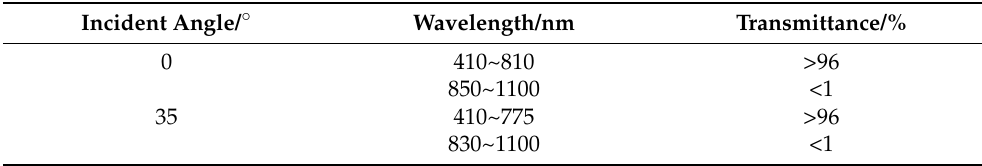
Table 1. Filter film parameters